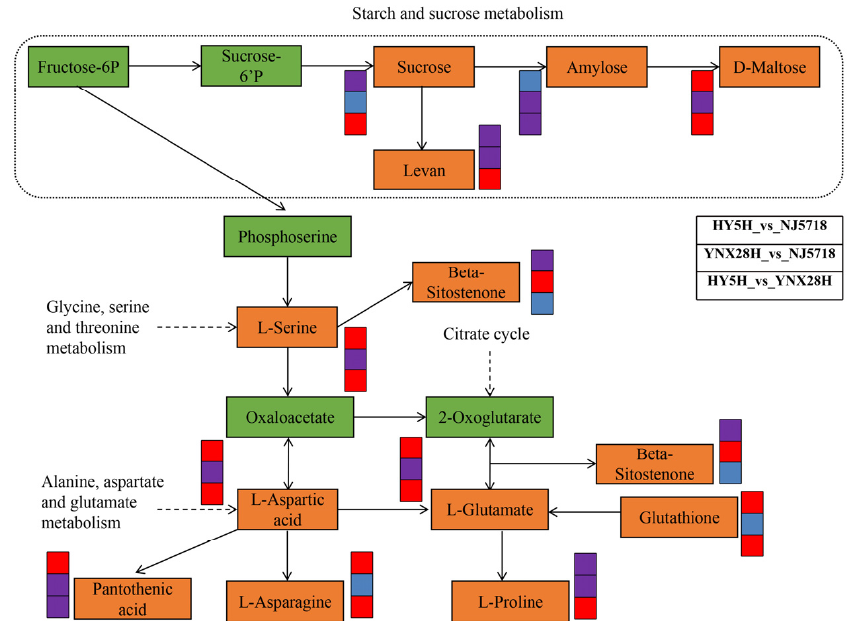
Figure 4. Correlation analysis of rice quality traits and DMs. * p < 0.05, ** p < 0.01, and *** p < 0.001. BR, brown rice rate; MR, milled rice rate; HMR, head milled rice rate; CR, chalkiness rate; CD, chalk- iness degree; GC, gel consistency; PC, protein content; AC, amylose content; AP, appearance; HA, hardness; VI, viscosity; BD, balance degree; TV, taste value.